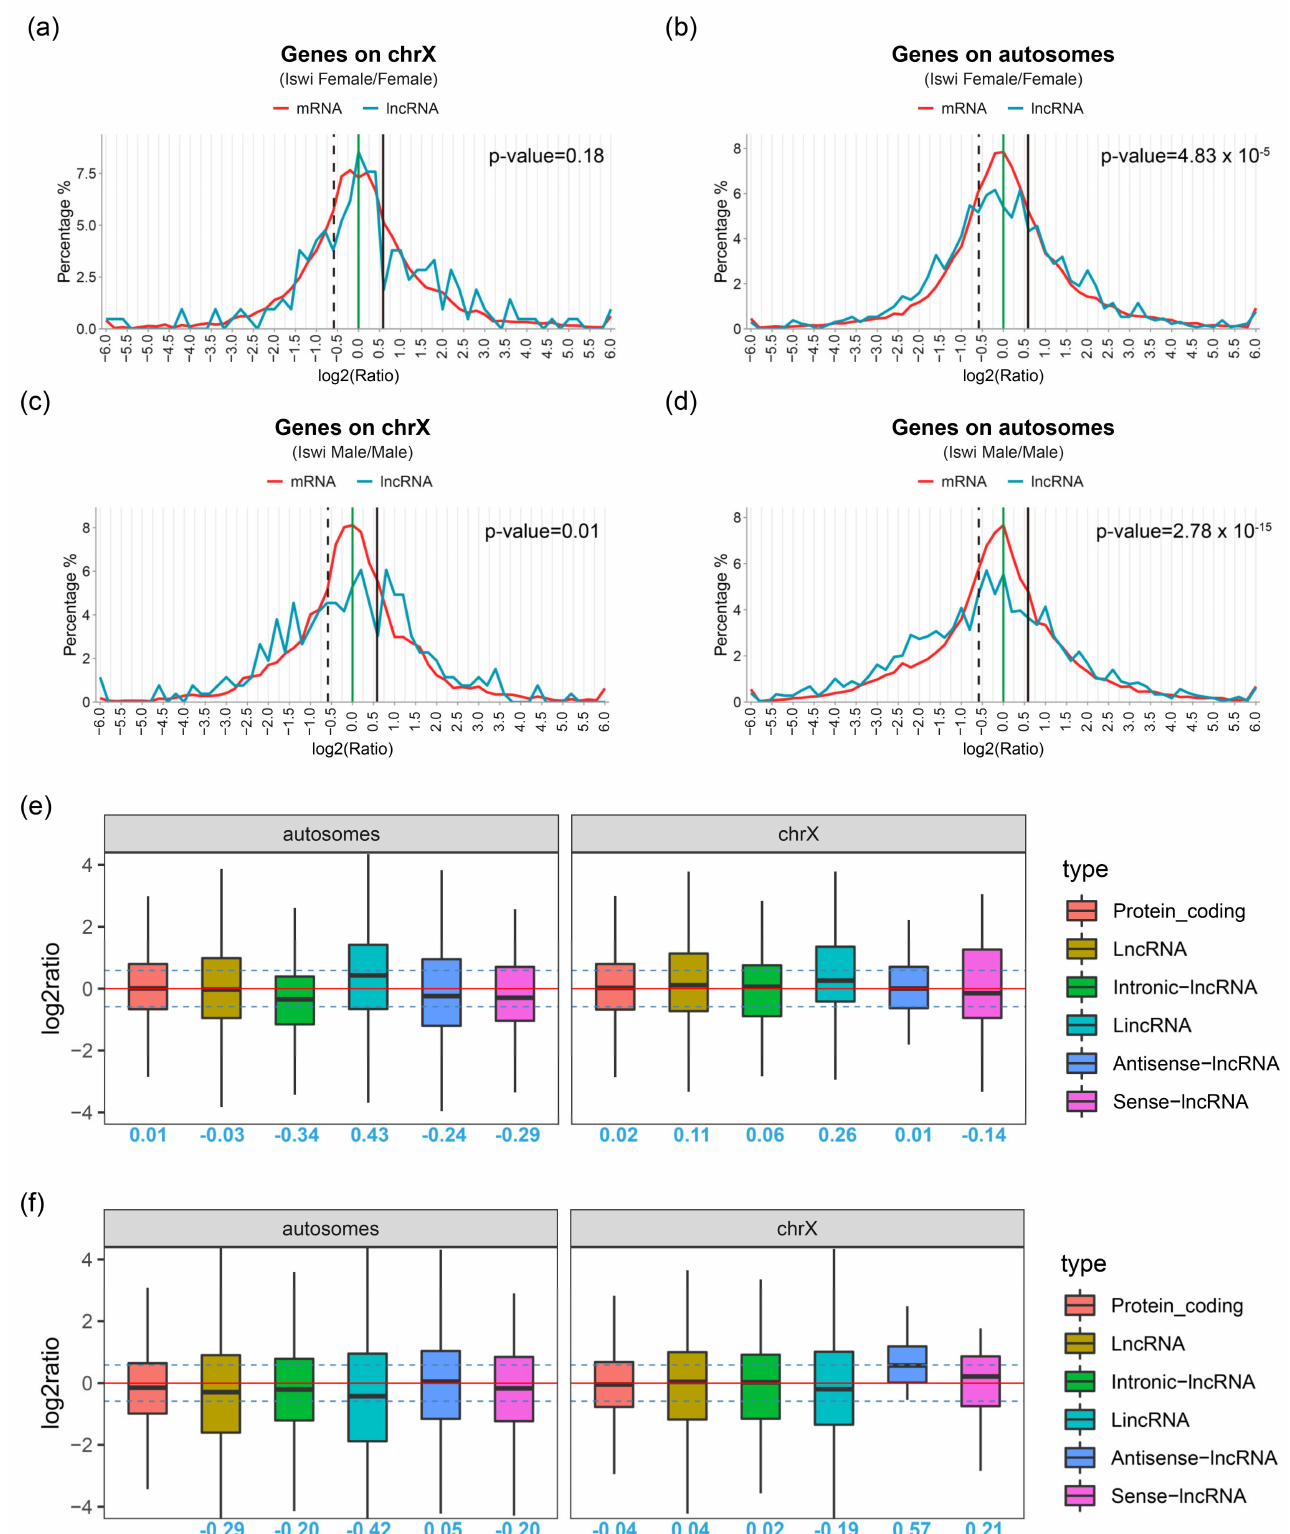
Figure 3. I Ratio distributions of transcripts expression in ISWI mutant compared with wild-type Drosophila . ( a , b ) Expression changes in transcripts on chrX ( a ) and on autosomes ( b ) in female. ( c , d ) Expression changes in transcripts on chrX ( c ) and on autosomes ( d ) in male. The x-axis is the logarithm base 2 of the ratio of the expression level of the transcript in the experimental group to